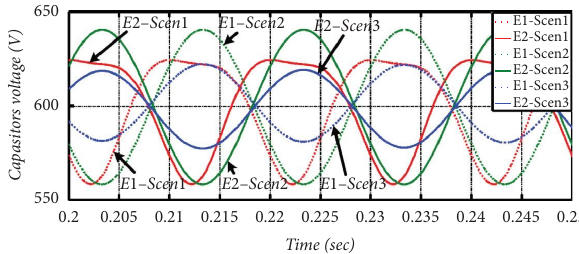
Figure 13: DC-link capacitor voltages for both proposed and conventional controller in various